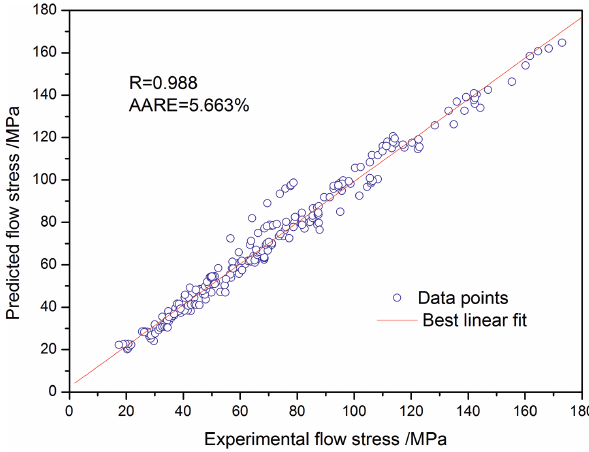
Figure 17: Correlation between the experimental and predicted flow stress data from SCA constitutive